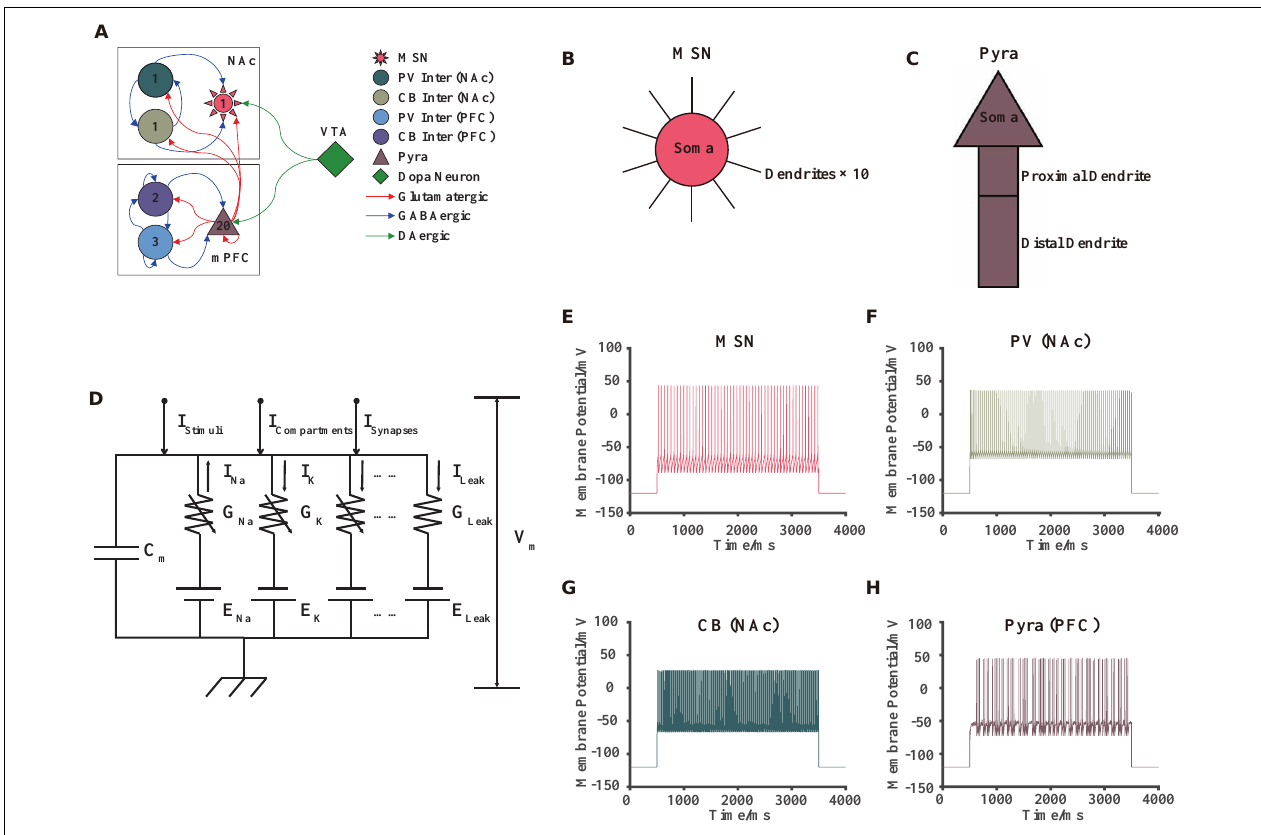
FIGURE 1 | VTA-NAc-mPFC neural network model. (A) The structure and synaptic connections of the neural network, different colors, and shapes corresponded to different types of neurons; numbers inside the shapes showed the amounts of the neurons in our model; the red, blue, and green arrows showed the glutamate, GABA and dopamine projections, respectively. (B,C) Structures of the MSN in NAc and pyramidal neurons in mPFC in our model, where the 10 dendrites of the MSN were the same. (D) The circuit schematic of the H-H model for an individual neuron, whose currents consisted of 4 different types: ionic currents I Ions , stimuli current I Stimuli , compartment currents I Compartments , and synaptic currents I Synapses . (E–H) Simulated membrane potential results of different types of neurons in our model, the stimuli began at 500 ms and ended at 3,500 ms, which successfully replicated the fast-firing pattern of interneurons and burst firing pattern of pyramidal neurons.